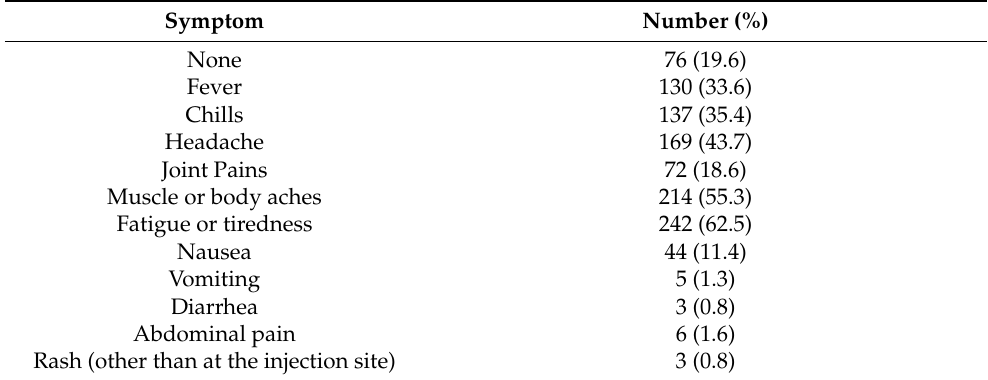
Table 2. Symptoms post-second-dose-vaccine, recorded at the fourth blood draw